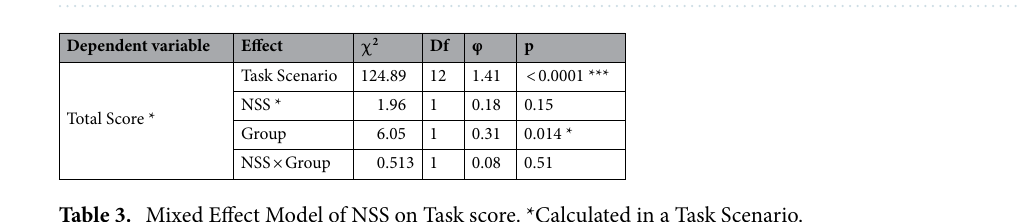
Figure 3. The figure shows evaluation of the SVM classifier trained on eye movement features. ( A ) Confusion matrix shows percentage of correctly classified and mislabeled participants per group averaged on tenfold cross validation, ( B ) the panel shows ROC curve and AUC scores for each cross-validation fold and the average.